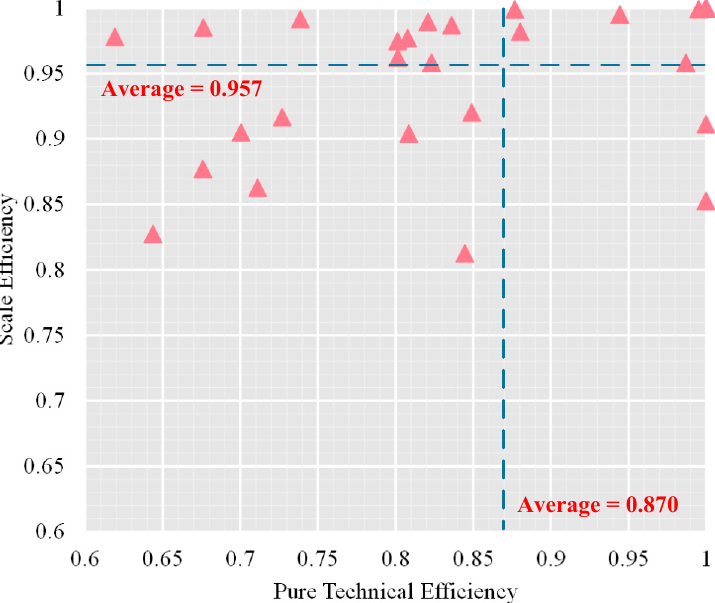
Figure 8. The pure technical efficiency and scale efficiency of 34 Chinese LED energy enterprises in 2018.